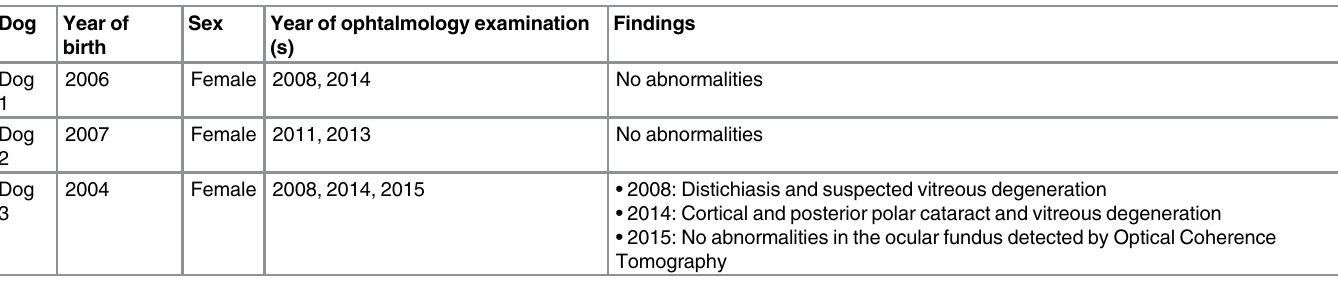
Table 2. Summary of ophtalmological examinations in the Brazilian